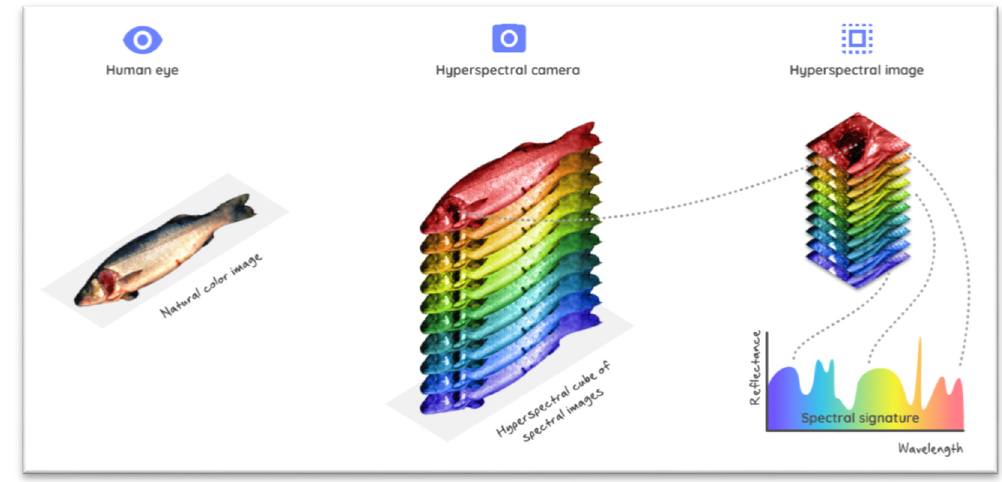
Figure 3. Hyperspectral data cube (hypercube) viewed as either an image at each individual wavelength or as a whole spectrum at each individual pixel of the image.